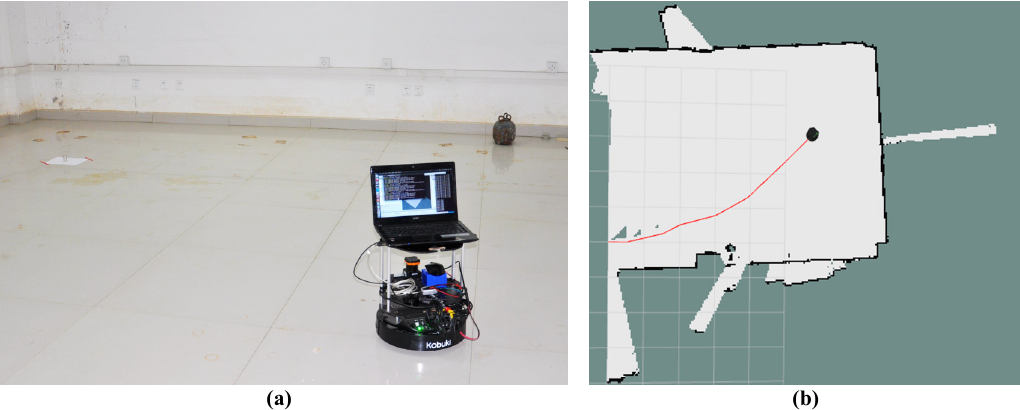
Figure 5. Real experiment. ( a ) Work scene graph of the robot searching for the radioactive source, ( b ) when N = 2, v = 0.2 m/s, ω = 0.1 rad/s, the map and trajectory map of the robot while automatically searching the radioactive source. Table 3. Error of radioactive source estimation in the real experiment.